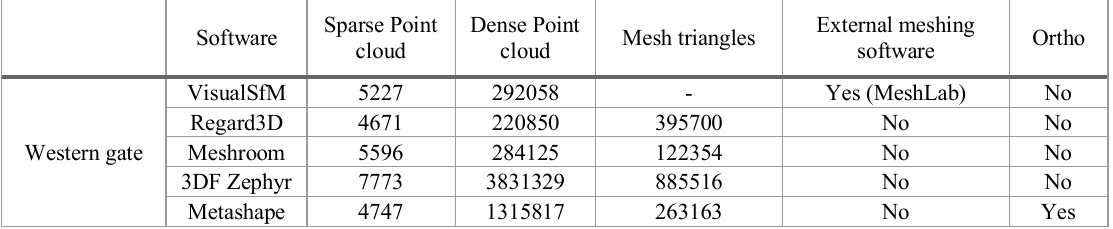
Table 6. Comparison between the results of each of tested software